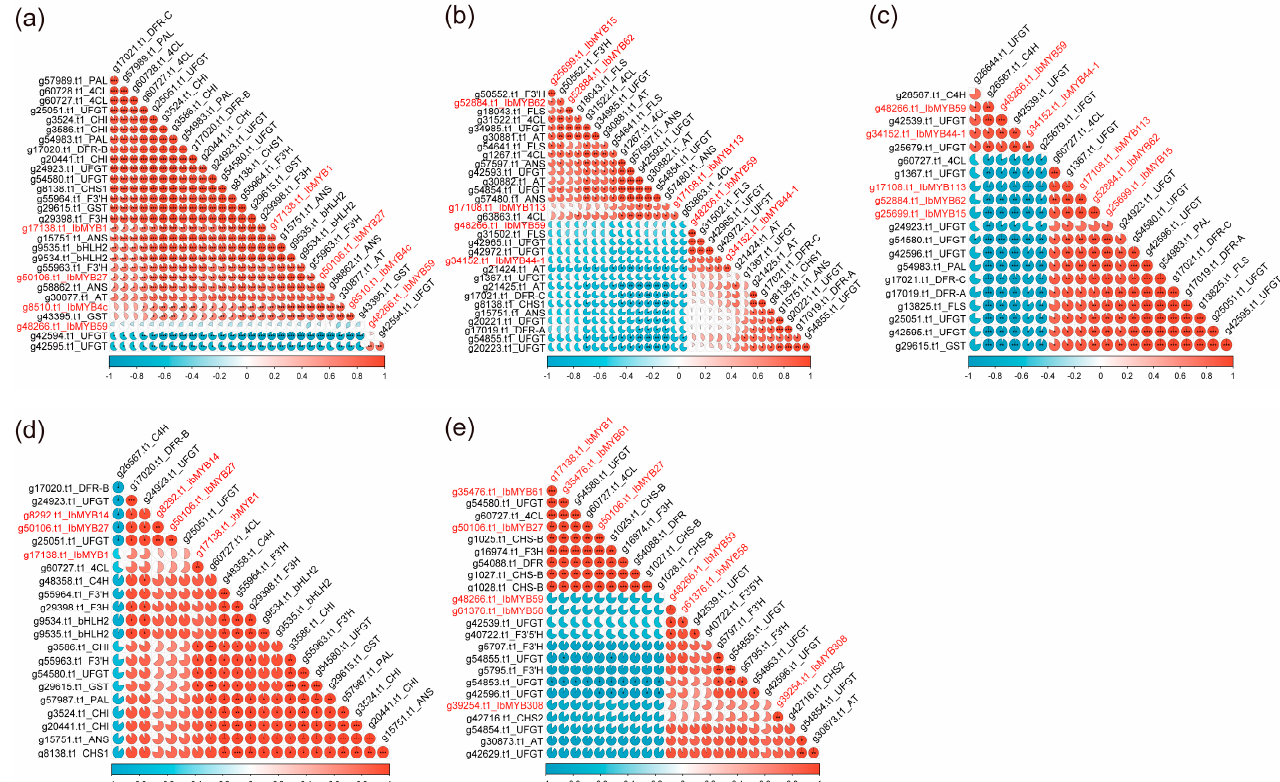
Figure 8. Pearson’s correlation analysis of di ff erentially expressed genes (DEGs) of IbR2R3-MYB and anthocyanin biosynthesis genes (ABGs) in di ff erent pigmented tissues of sweet potatoes. ( a ) IbR2R3-MYB s and ABGs in white, yellow, and purple fl eshes. ( b , c ) IbR2R3-MYB s and ABGs in red and yellow skins. ( d , e ) IbR2R3-MYB s and ABGs in green and purple leaves. The pie charts show the Pearson correlation coe ffi cient values. The red and blue colors represent the positive and negative correlation, respectively. The asterisk shows the p -value, * p < 0.05, ** p < 0.01, and *** p < 0.001.